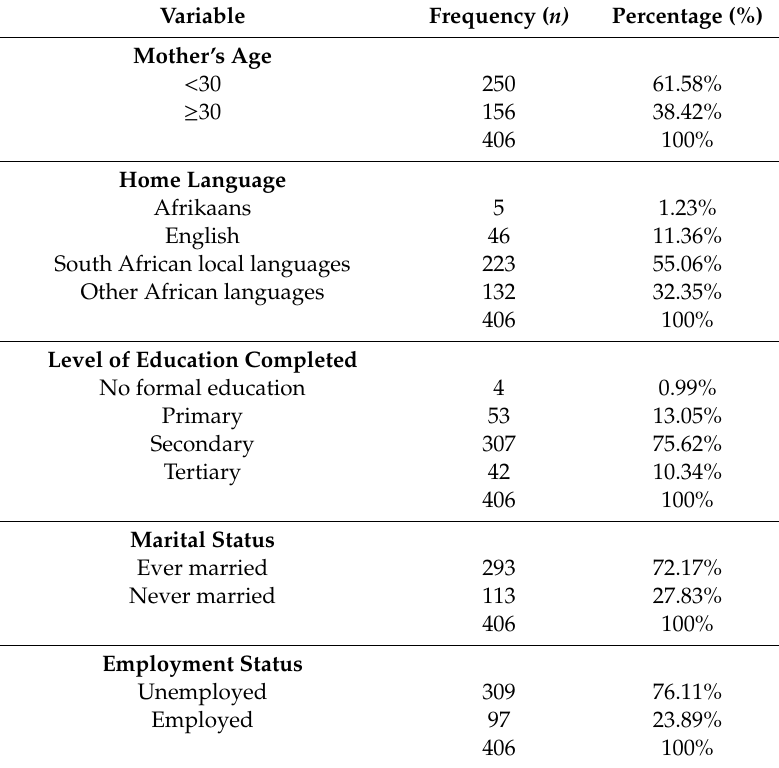
Table 1. Sociodemographic characteristics of the